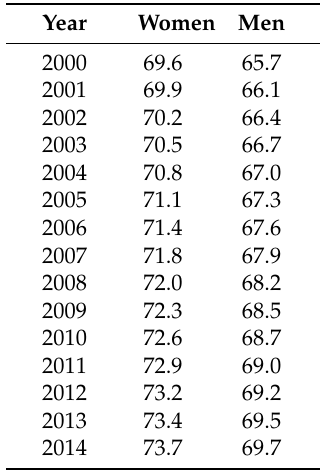
Table 1. Change of life expectancy in all 65 Belt and Road countries, 2000–2014.